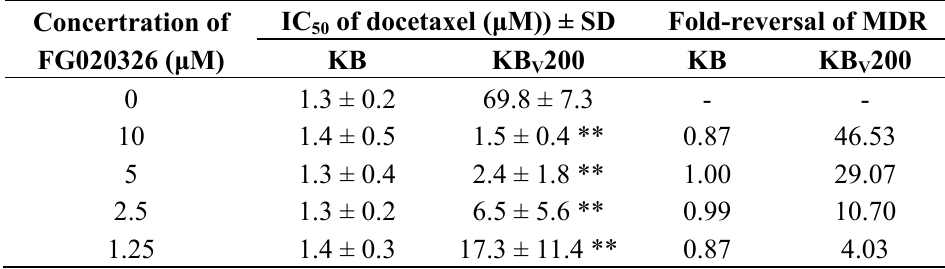
Table 1. Enhancement of sensitivity to docetaxel (TXT) induced by FG020326 in KB and KBv200 cells. The IC of docetaxel was determined in the presence of various 50 concentrations of FG020326. Each value represents the mean ± standard deviation (S.D.) of at least three independent experiments. The fold-reversal of MDR is defined as the ratio of the IC for docetaxel alone versus the IC for docetaxel in the presence of the 50 50 modulating agent.